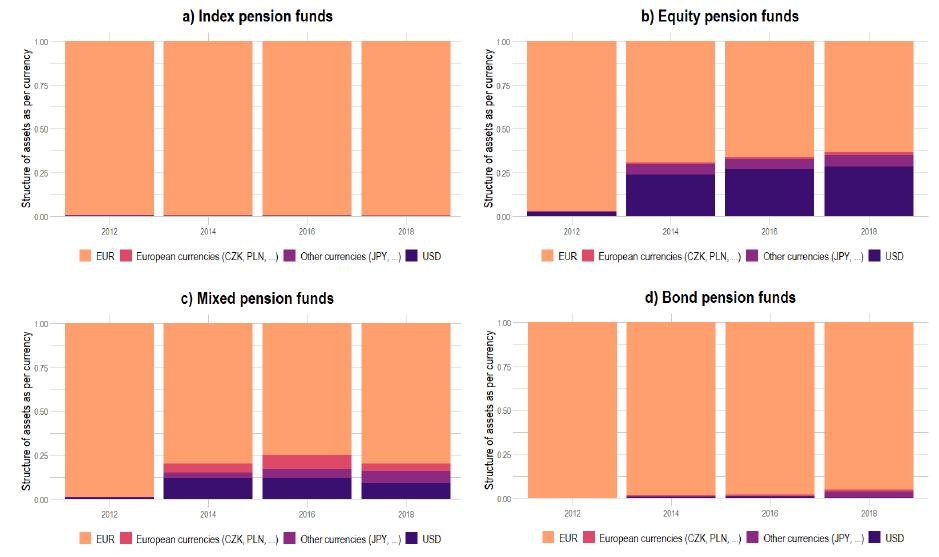
Figure 2. Structure of assets as per currency for